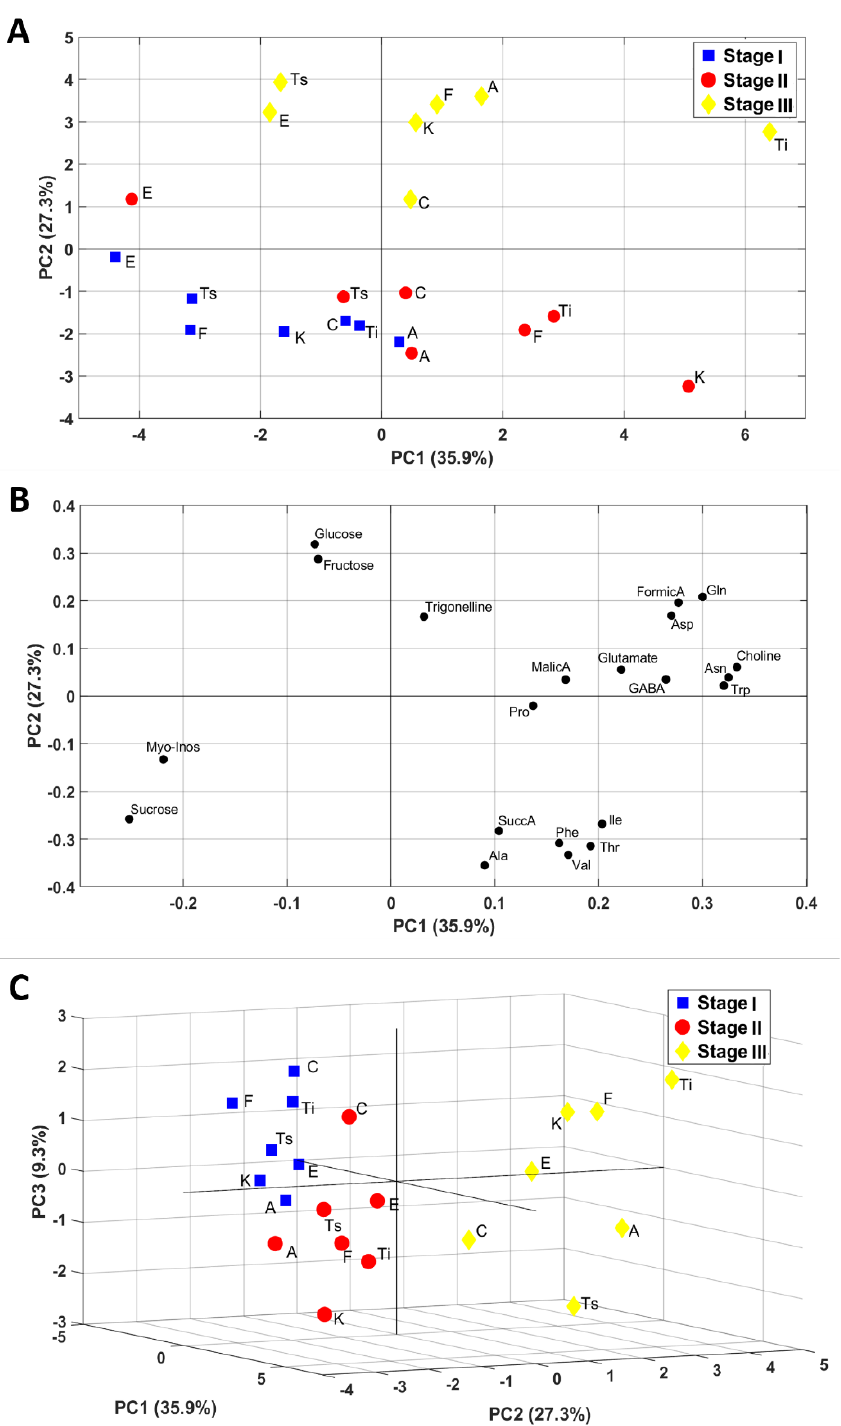
Figure 1. Principal components analysis (PCA) maps obtained using NMR data of inflorescences samples: ( A ) scores plot and ( B ) loadings plot relative to PC1 and PC2 (PCs); ( C ) score plot relative to PC1, PC2, and PC3. PC1, PC2, and PC3 represent 35.9%, 27.3%, and 9.3% of the total variance, respectively.